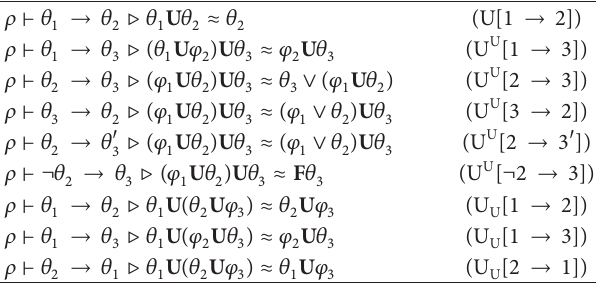
Table 5: Reduction rules for formulae involving adjacent past and future operators.